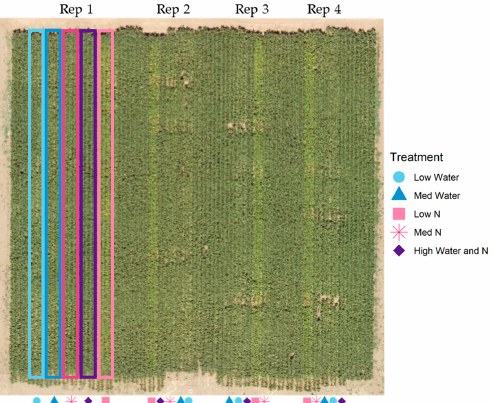
Figure 1. A map representing the treatment structure consisting of replicates (Rep) and water and nitrogen (N) treatments at the Russell Ranch 2018 site. Table 1. A description of the applied nitrogen and irrigation treatments imposed at all sites included in this study.